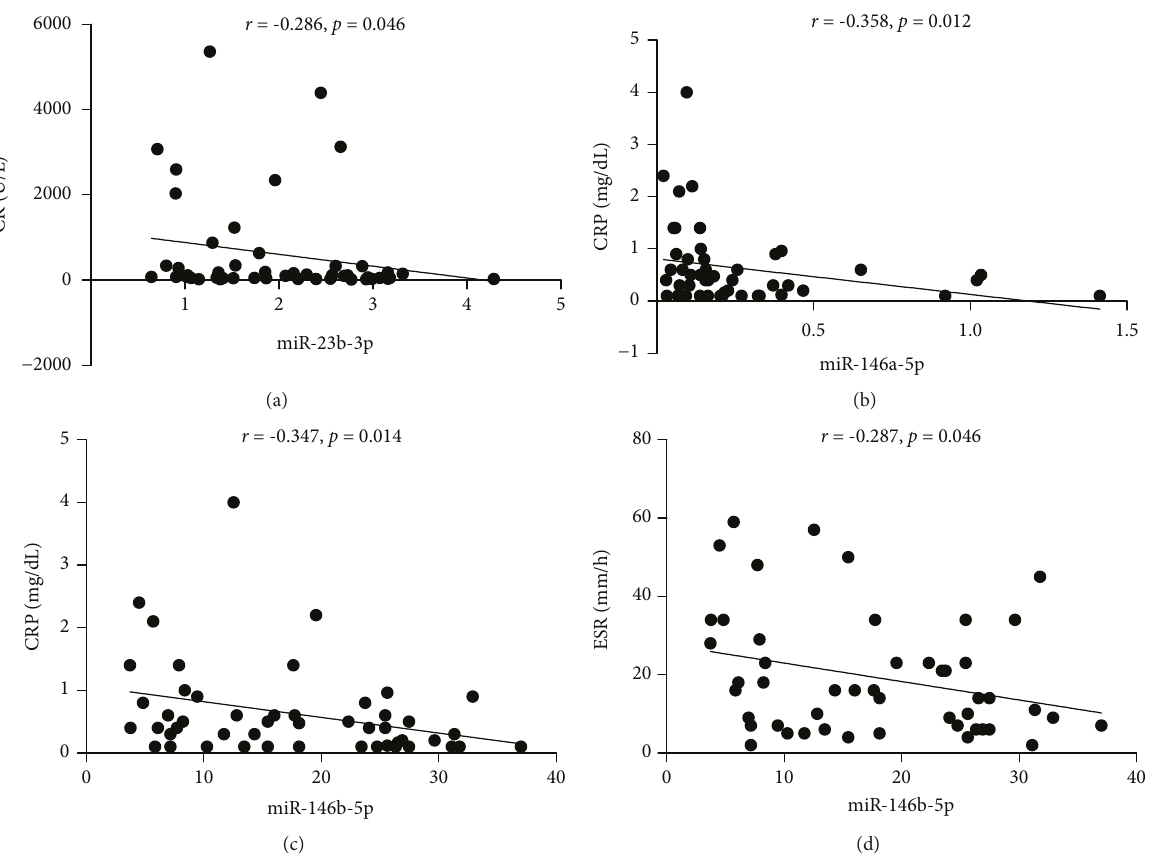
Figure 2: Correlations between miR-23b-3p, miR-146a-5p, and miR-146b-5p and clinical laboratory parameters of DM. (a) The results showed that miR-23b-3p expressions were negatively correlated with CK ( r = − 0 286 , P = 0 046 ). (b) Serum miR-146a-5p levels were signi fi cantly correlated with CRP ( r = − 0 358 , P = 0 012 ). (c, d) Signi fi cant correlations were observed between miR-146b-5p levels and CRP ( r = − 0 347 , P = 0 014 ) and ESR ( r = − 0 287 , P = 0 046 ). Data were analyzed by Spearman ’ s rank correlation coe ffi cient. All P values were two-sided, and P value < 0.05 was statistically considered signi fi cant. DM: dermatomyositis; CRP: C-reactive protein; ESR: erythrocyte sedimentation rate; CK: creatine kinase; LDH: lactate